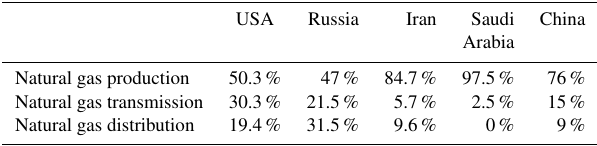
Table 5. Share of CH 4 emissions in sector 1.B.2.b (fugitive emis- sions from natural gas) for the five top emitting